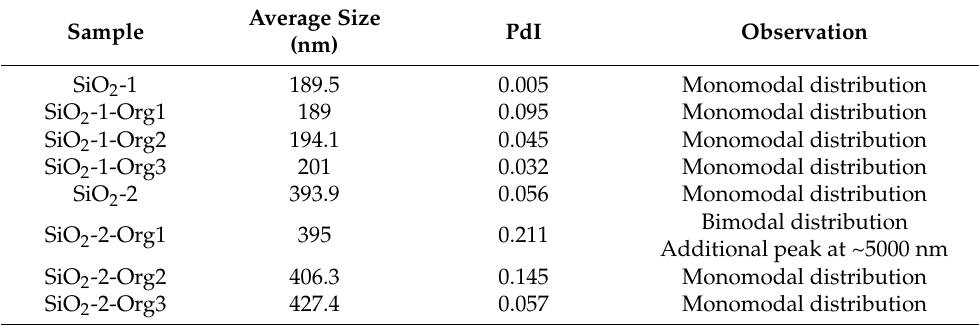
Table 2. Size and size distribution of silica dispersion obtained in the microwave-assisted method.